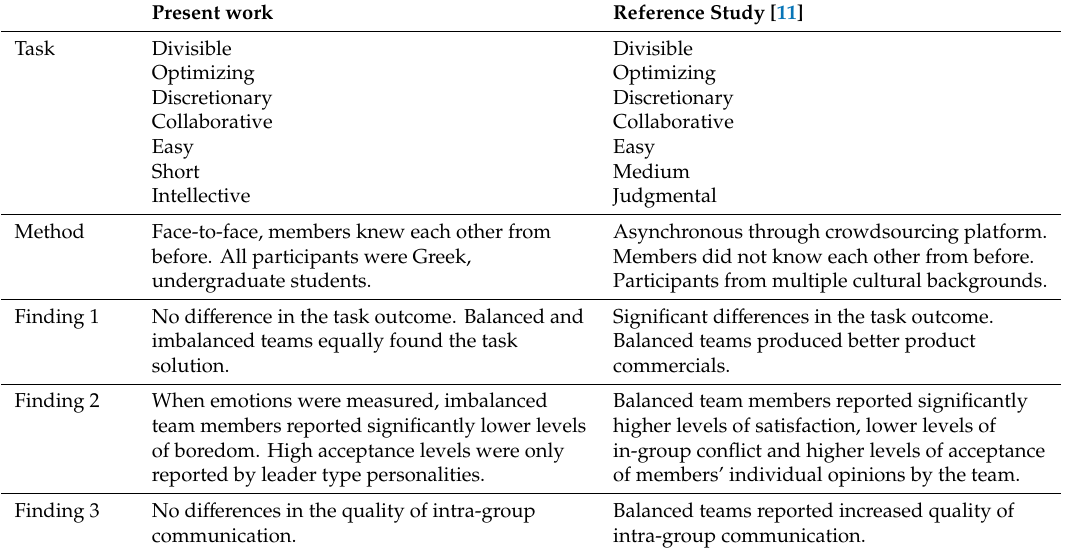
Table 3. Comparison of current study with reference study